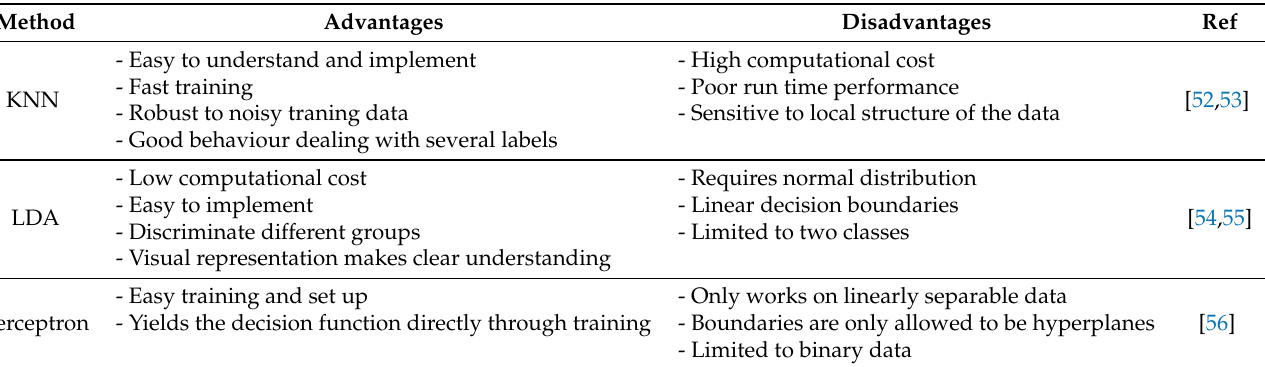
Table 1. Advantages and disadvantages of the